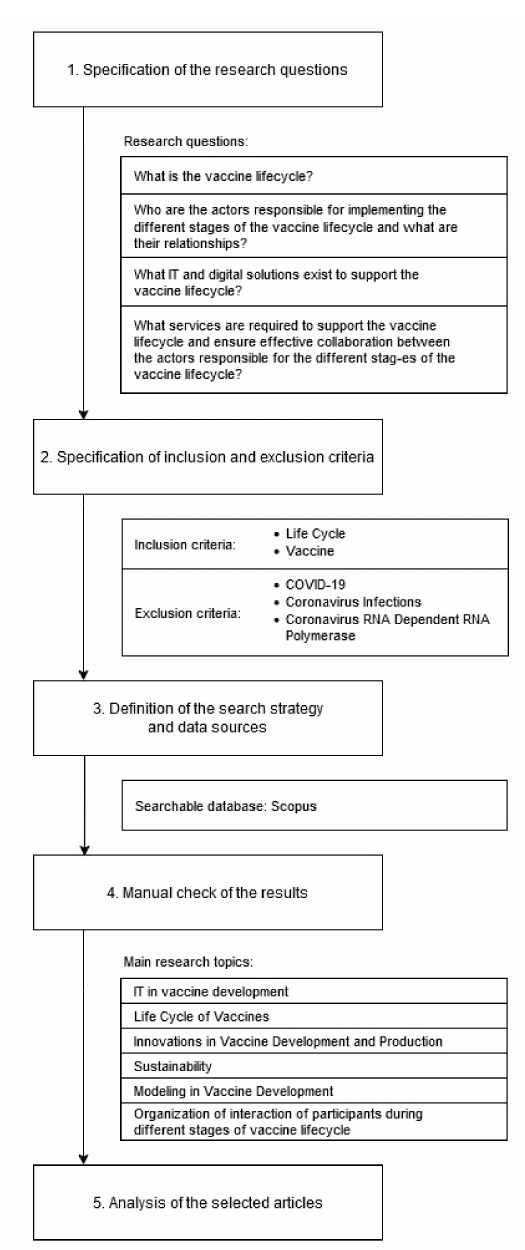
Figure 1. Literature review methodology